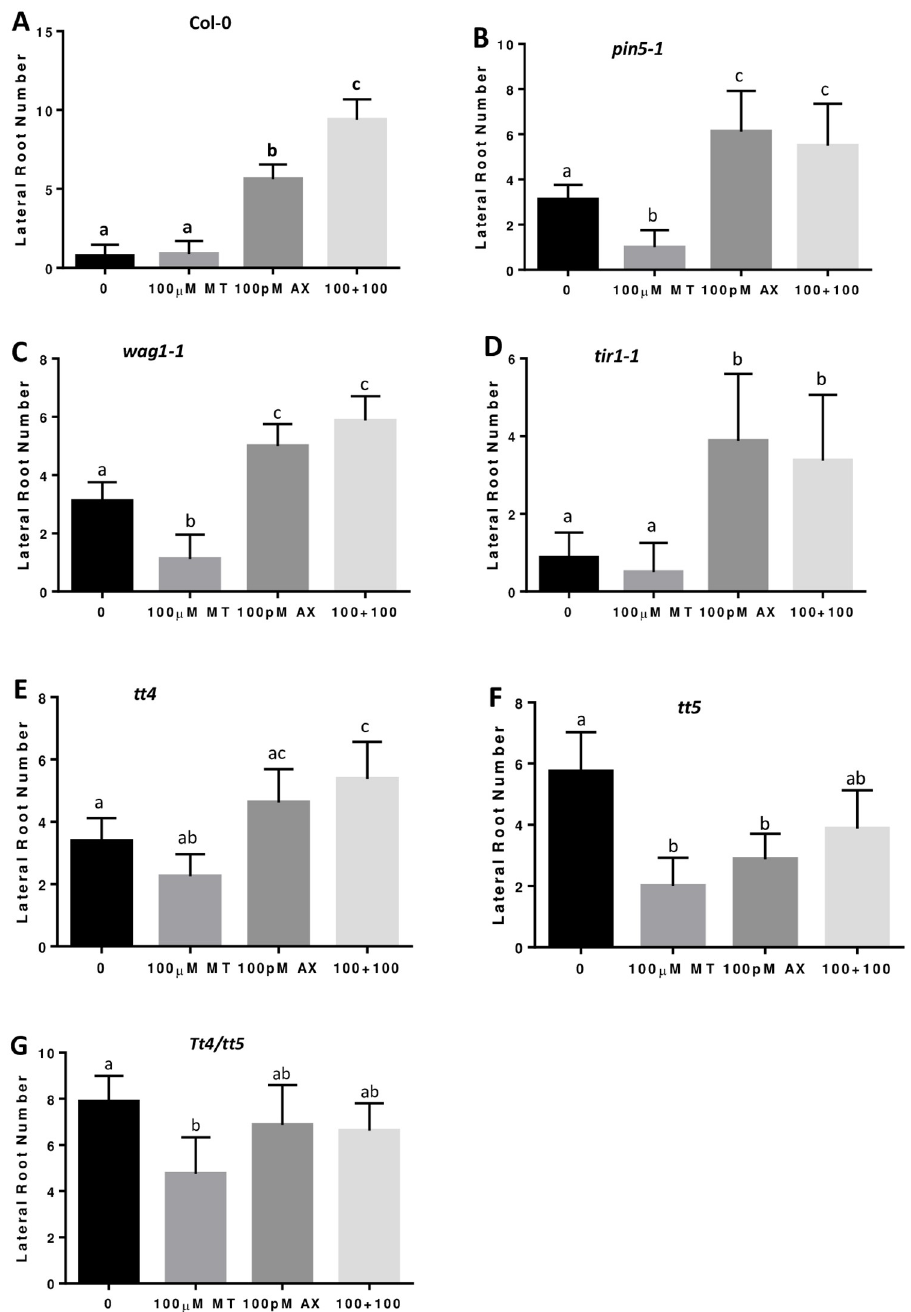
Fig 5. Synergistic effect of melatonin and auxin on lateral root development is abolished in auxin-transport- related mutants. Lateral root number of Arabidopsis seedlings from wild type Col-0 (A), pin5-1 (B), wag1-1 (C), tir1-1 (D), tt4 (E), tt5 (F) and tt4/tt5 double mutant (G), growing on medium with control, 100 μ M melatonin, 100pM 2,4-D and the combination. Three independent experiments with more than 15 seedlings per measure were conducted for statistical analysis. Values represent Mean ± SD. Different letters indicate significant differences according to Duncan’s multiple range test (P < 0.05).